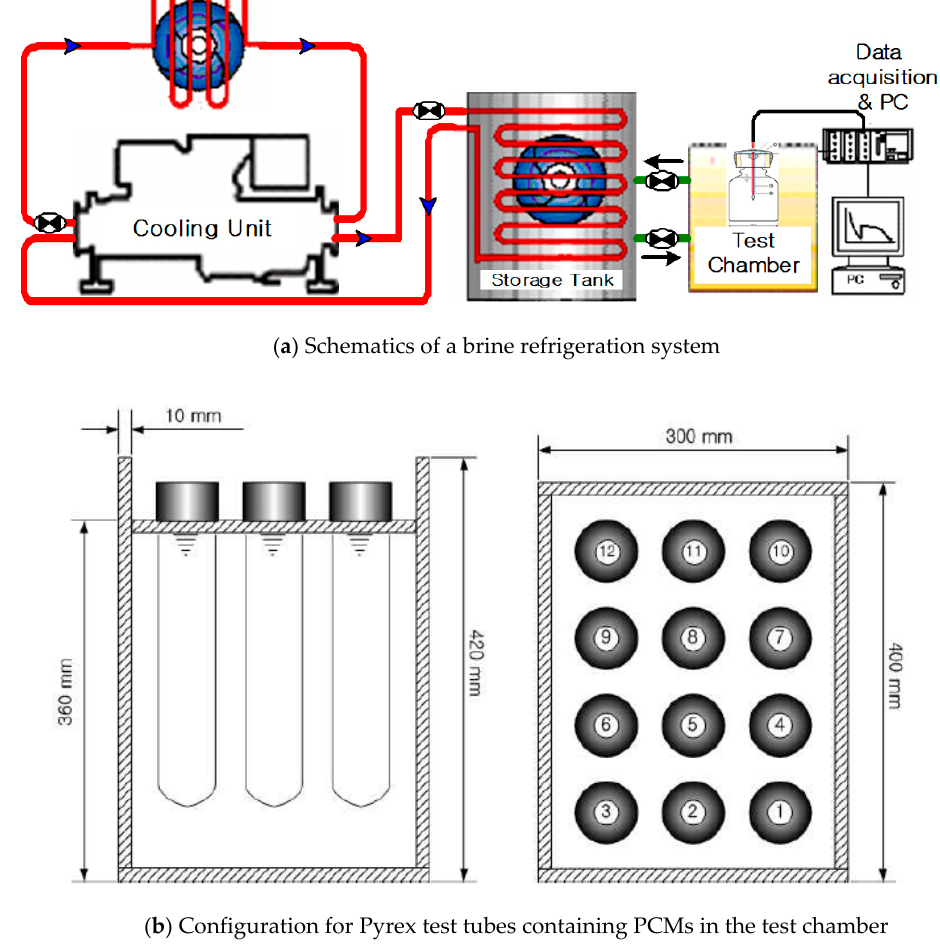
Figure 2. Experimental apparatus used for the T ‐ history method.